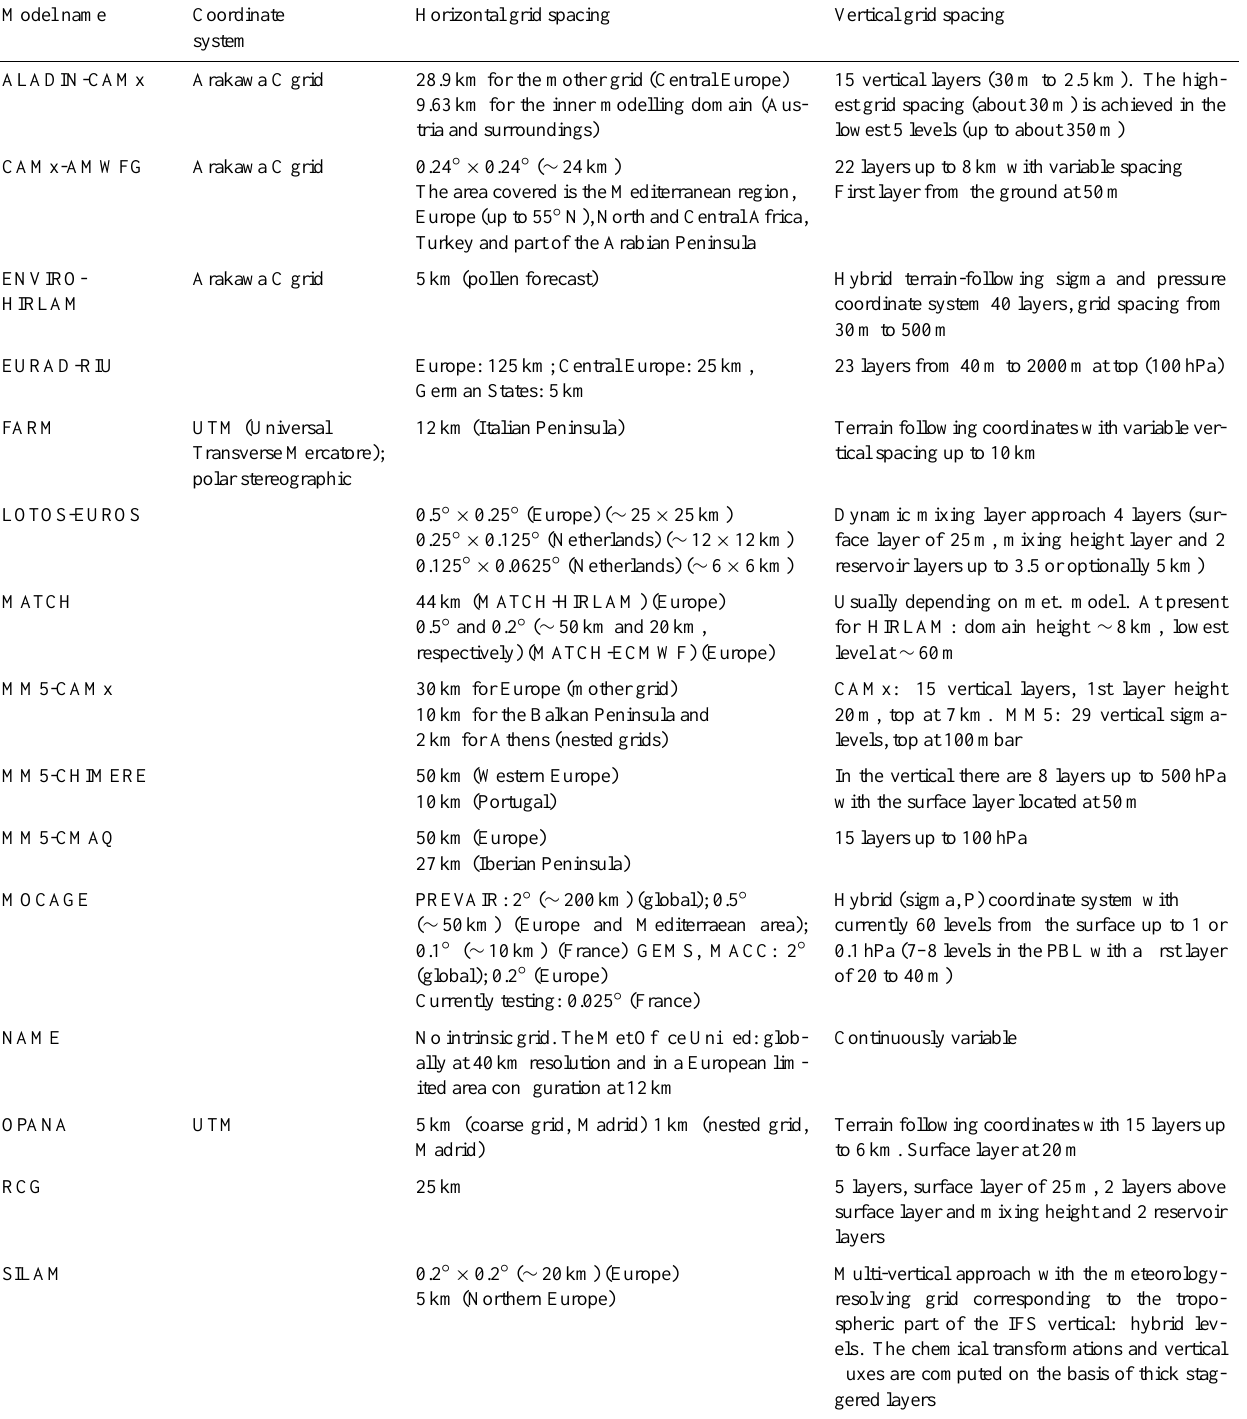
Table 9. Details on the grid spacings and coordinate systems of the different CWF